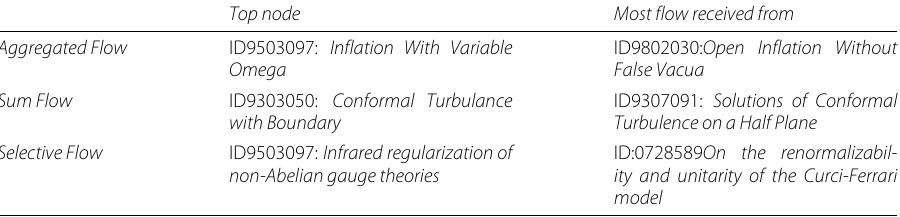
Table 4 Information of the most relevant publication and their main influence as discovered with the different multiplex flows among the (#citations=10, h -index=6) publication